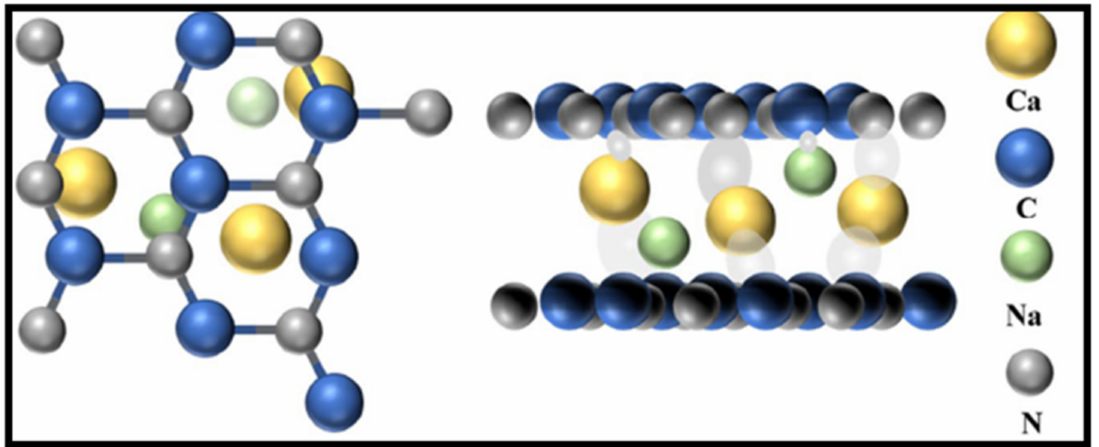
Figure 14. A schematic diagram of Na, Ca-GCN. Reproduced with permission from Ref.